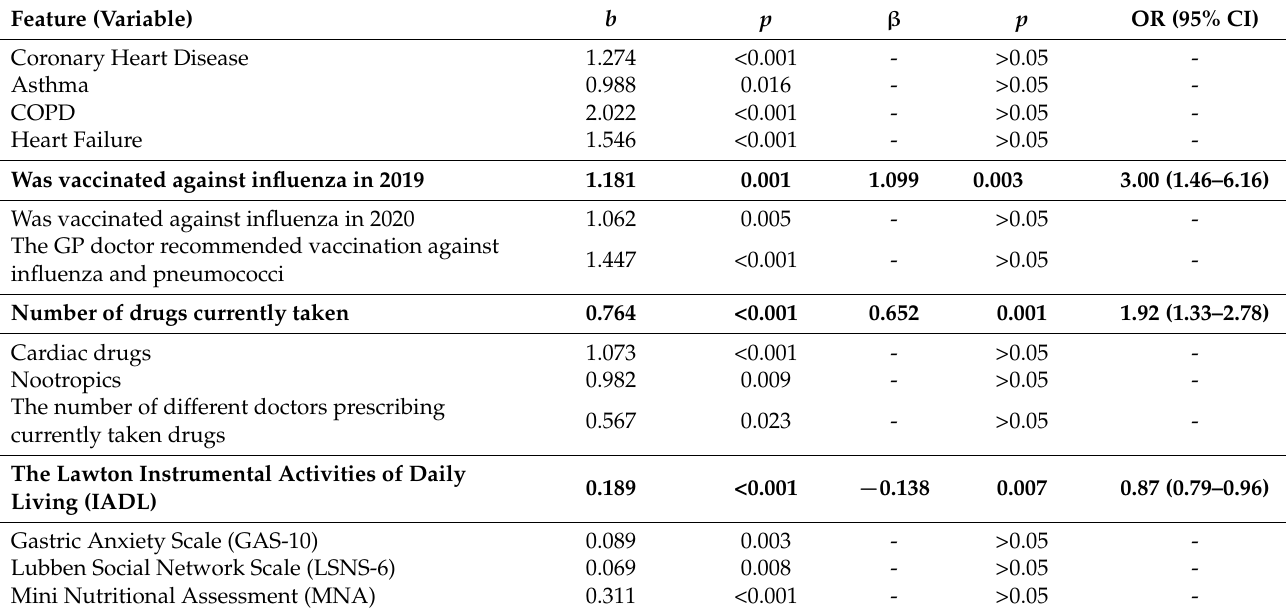
b —linear regression coefficient, β —standardized multiple regression coefficients.